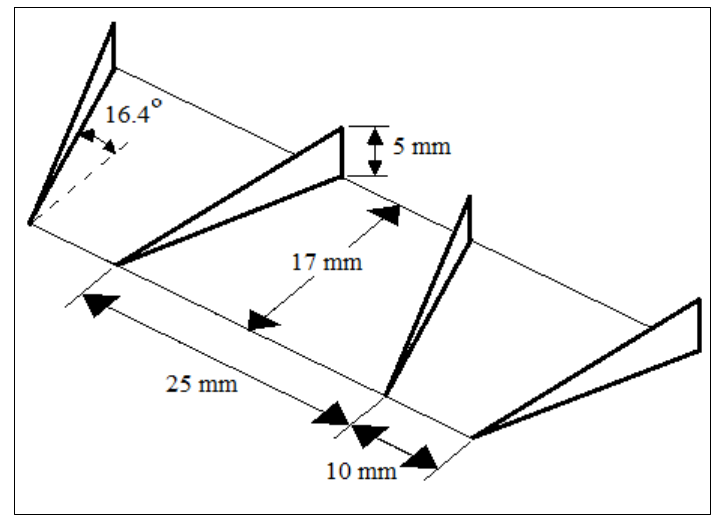
Figure 2. The geometric parameters of the considered VGs